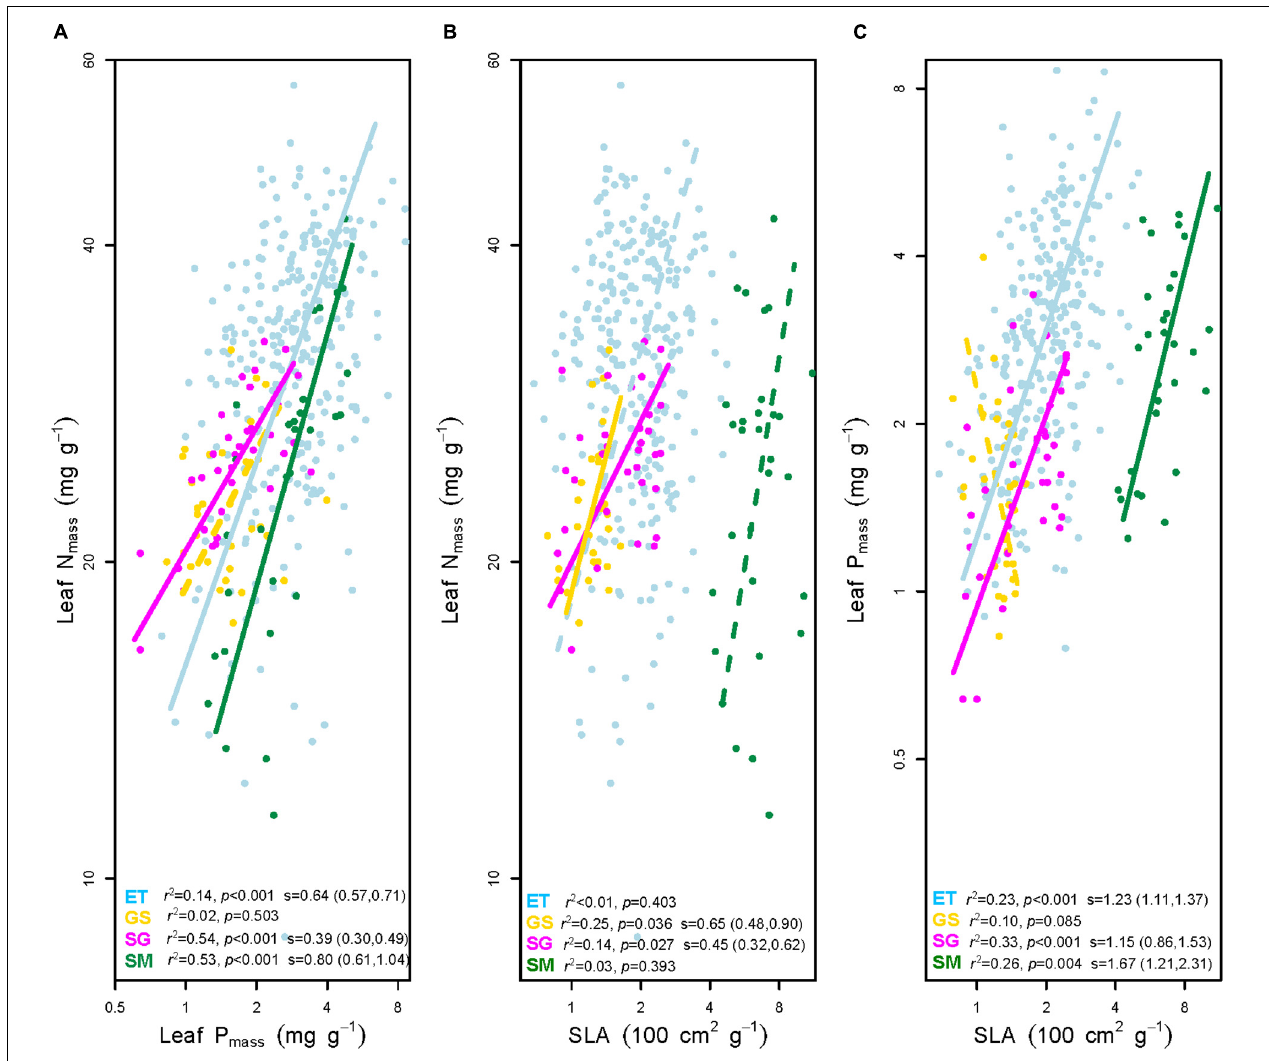
FIGURE 4 | Bivariate correlations between mass-based leaf nitrogen concentration (N mass ), mass-based leaf phosphorus concentration (P mass ), and specific leaf area (SLA). (A) Leaf N mass vs. leaf P mass . (B) Leaf N mass vs. SLA. (C) Leaf P mass vs. SLA. ET, emergent plants, GS, grasses, SG, sedges, and SM, submerged plants. Solid lines denoted that the two traits correlated with each other at significance level p < 0.05, while the dashed lines showed non-significant correlations. The coefficients of determination ( r 2 ) and p values for trait-trait correlations were given on the bottom of each panel. The slopes ( s ) with 95% confidence interval of each regression line were added only if p <